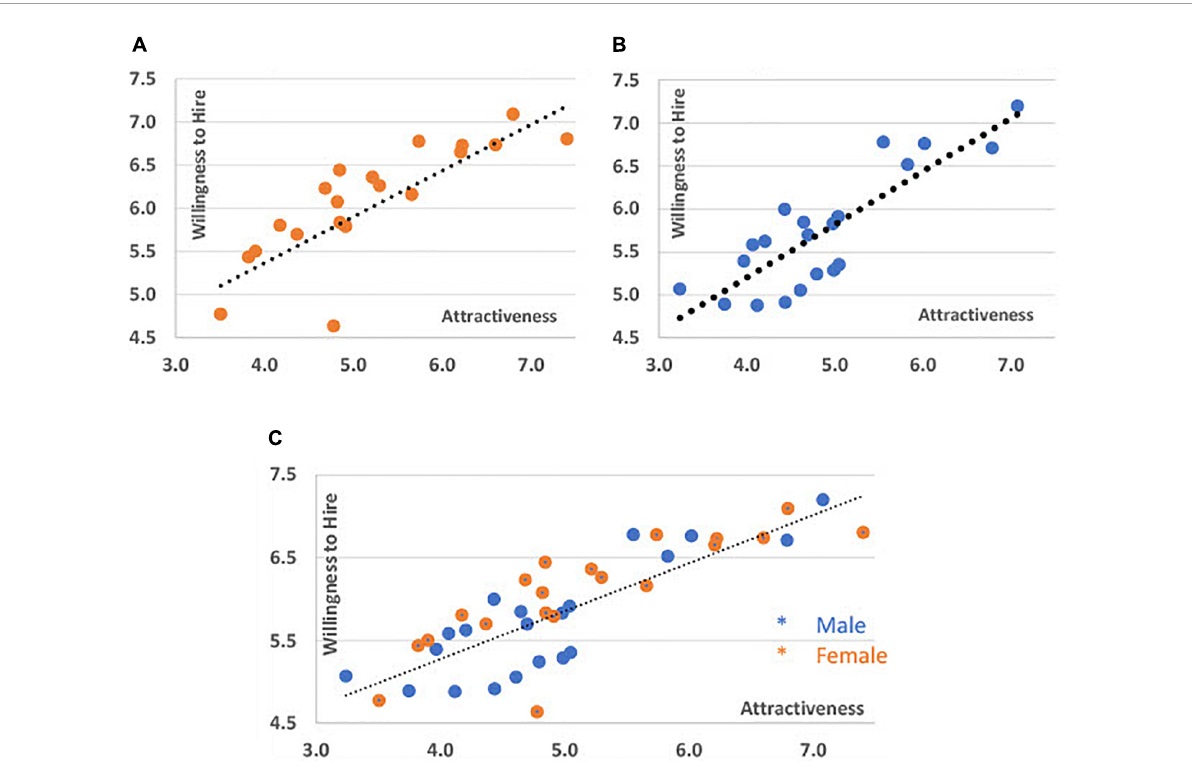
FIGURE1 Willingness to hire and attractiveness. This figure shows the willingness to hire (Y) and attractiveness (X) by male candidates [panel (A) ], female candidates [panel (B) ], and all candidates [panel (C) ]. Each point represents the average score of a single candidate rated by 298 employers (willingness to hire) and 809 students